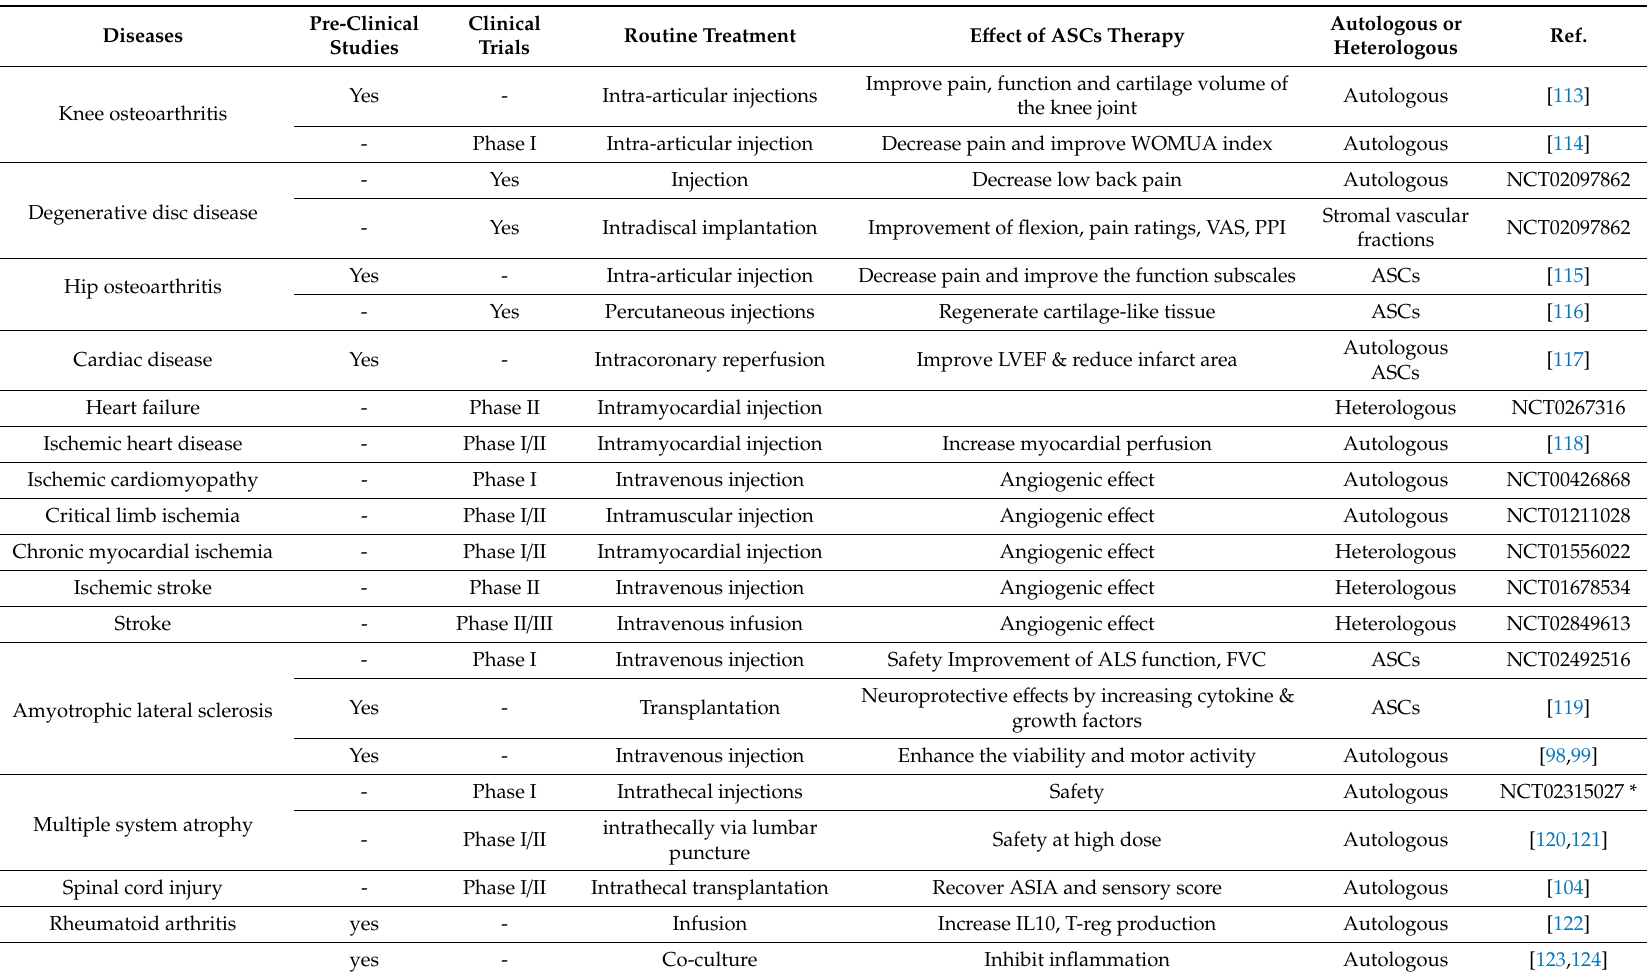
Table 3. Preclinical studies and clinical trials of adipose stem cells (ASCs)